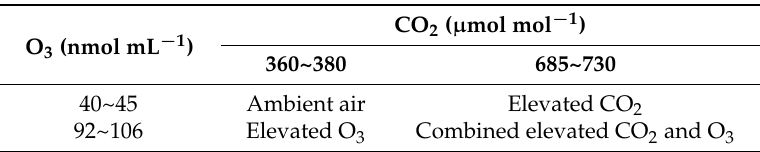
Table 1. 2 × 2 factorial